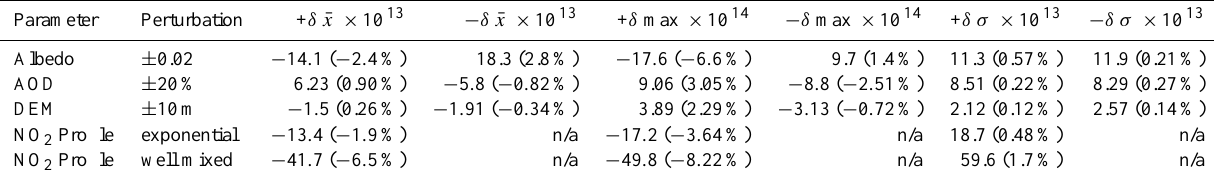
Table 7. Perturbation study results showing absolute and relative mean uncertainties ( ± δ ¯ x ), maximum uncertainties ( ± δ max) and standard deviations ( ± δ σ ) for five perturbation scenarios. The NO 2 profile shape study involves two alternative profile shapes (see Fig. 17); the results for each are presented in the + perturbation cells only. The units of the absolute uncertainties are in moleccm − 2